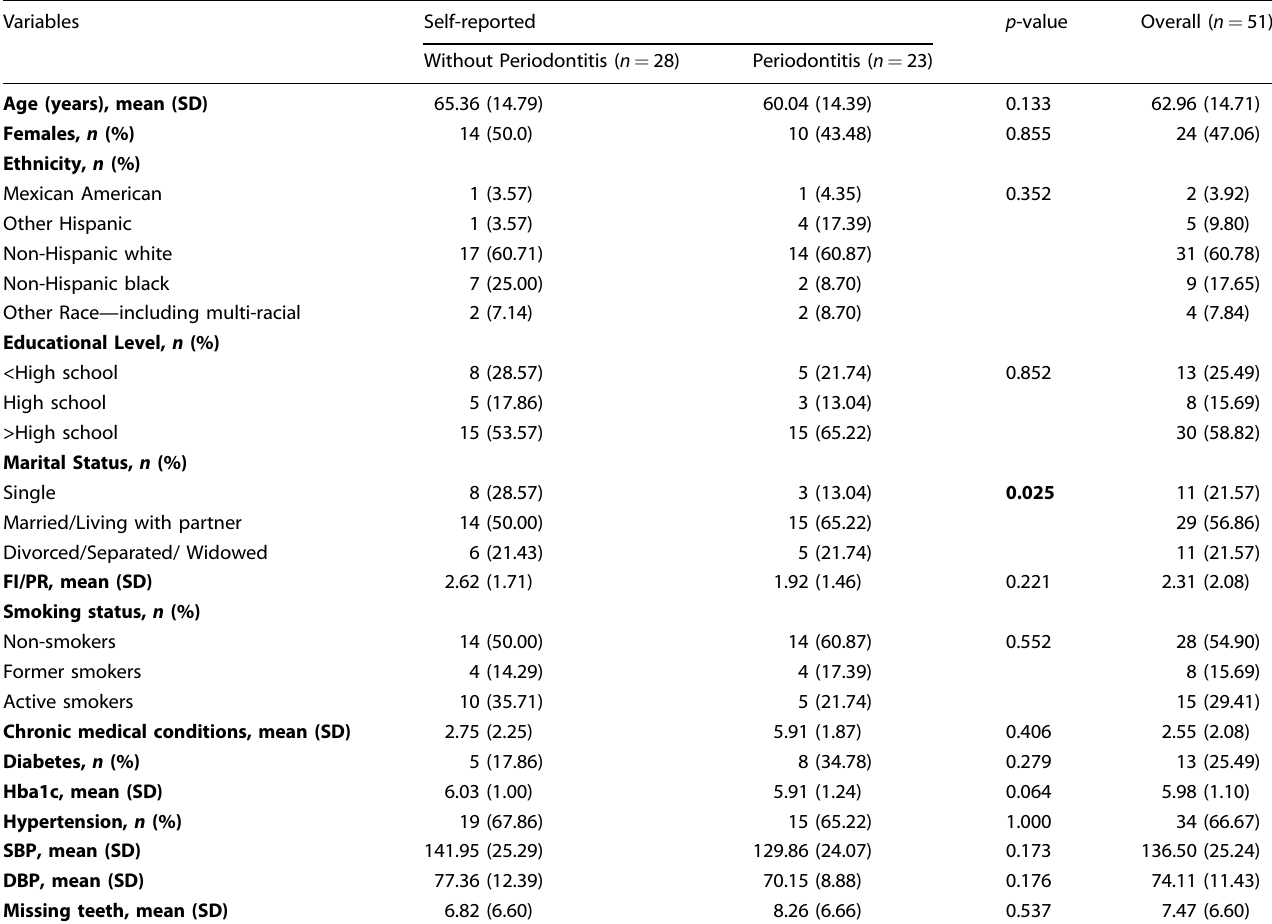
Table 1. General characteristics of PD patients according to the self-report of